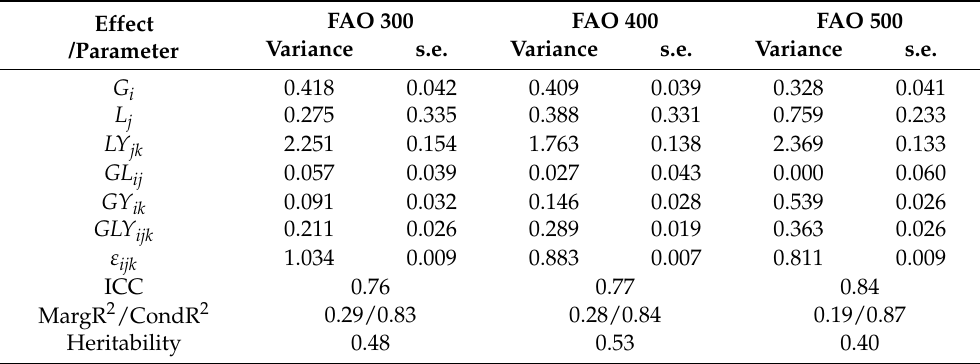
Table 1. Estimated variance components and associated standard errors (s.e.) for yield of maize from official Croatian variety trials in the period 2001–2019 along with intraclass correlation coefficients (ICC), values of Marginal R 2 /Conditional R 2 (MargR 2 /CondR 2 ) and heritability